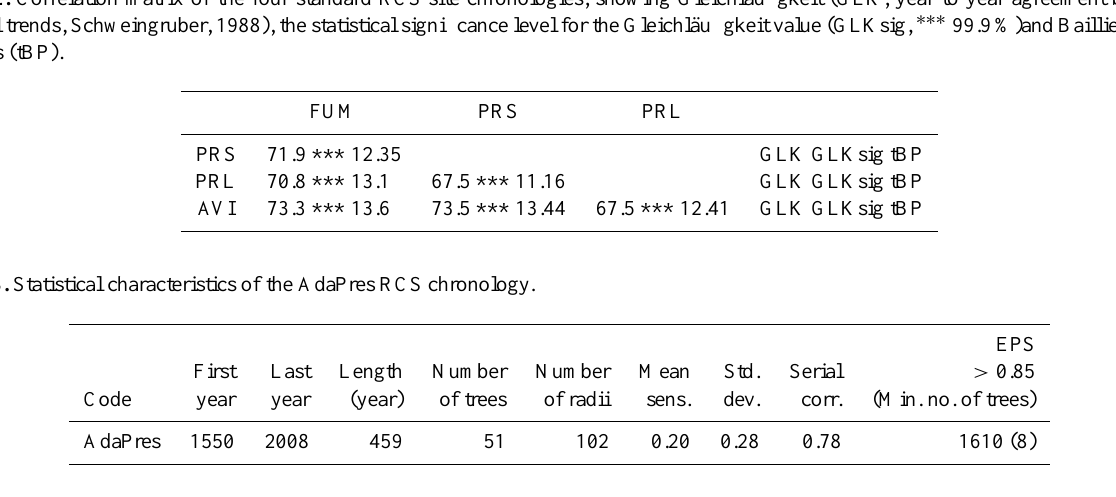
Table 2. Correlation matrix of the four standard RCS site chronologies, showing Gleichl¨aufigkeit (GLK, year-to-year agreement between interval trends, Schweingruber, 1988), the statistical significance level for the Gleichl¨aufigkeit value (GLKsig, ∗∗∗ 99.9%)and Baillie Pilcher t-values (tBP).